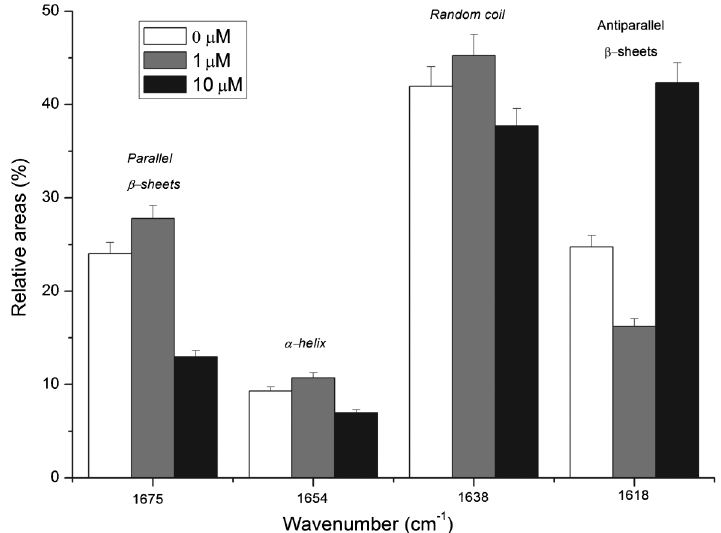
Figure 5. Protein secondary structure distribution in cells treated with 0, 1, or 10 m M celecoxib. Irregular distribution of b -sheets, a -helixes, and random coils are